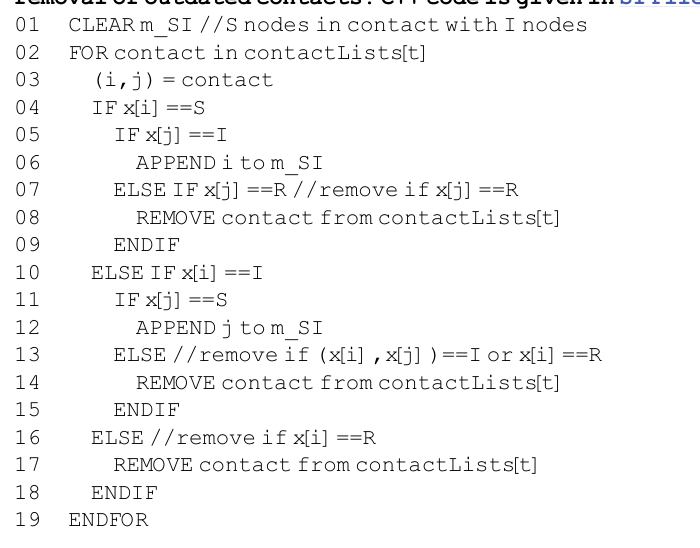
Pseudocode 3: Pseudocode for counting possible S ! I transitions with